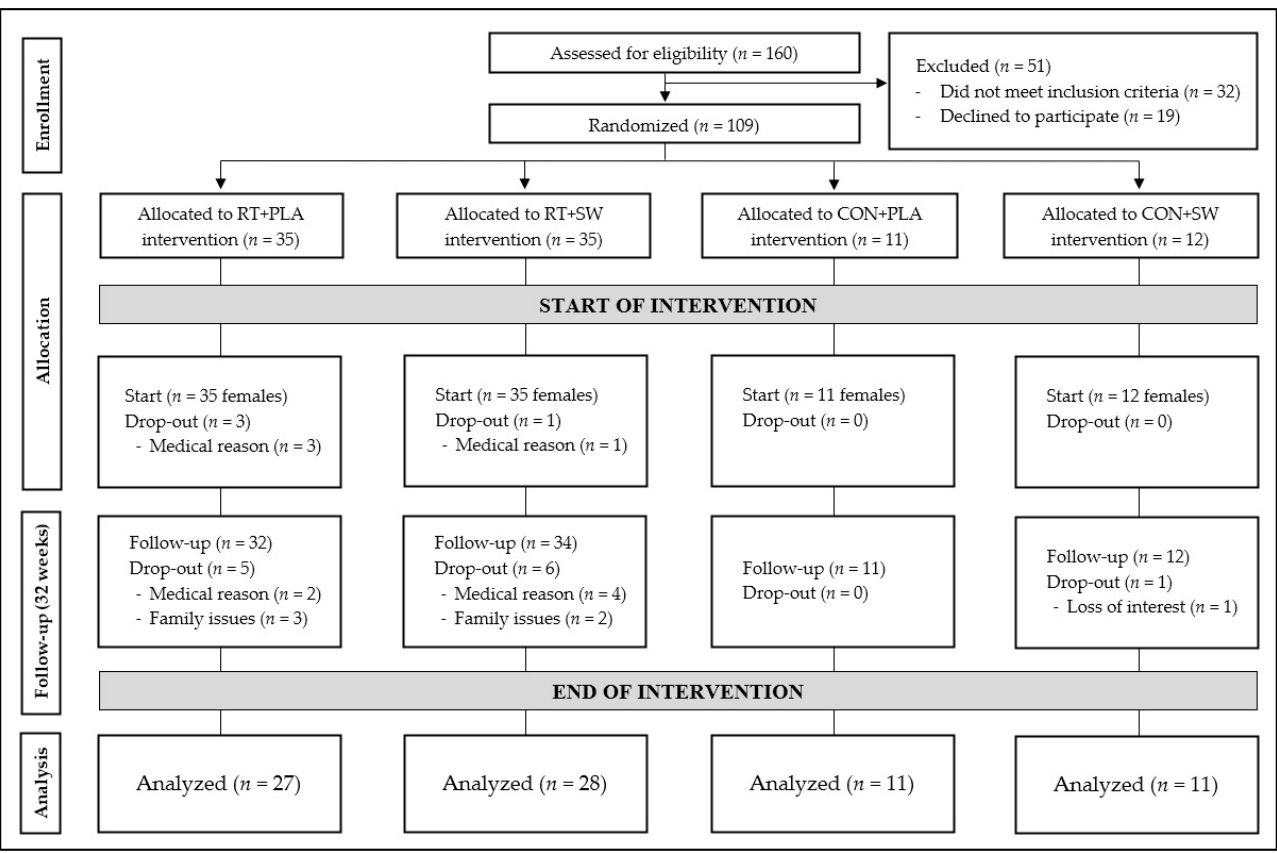
Figure 1. Flowchart of participation. RT: resistance training; PLA: placebo; SW: microfiltered seawater; CON: control group.